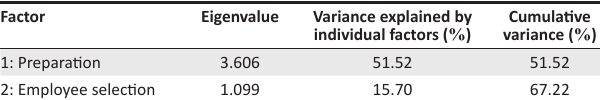
TABLE 2: Eigenvalues and variance explained.